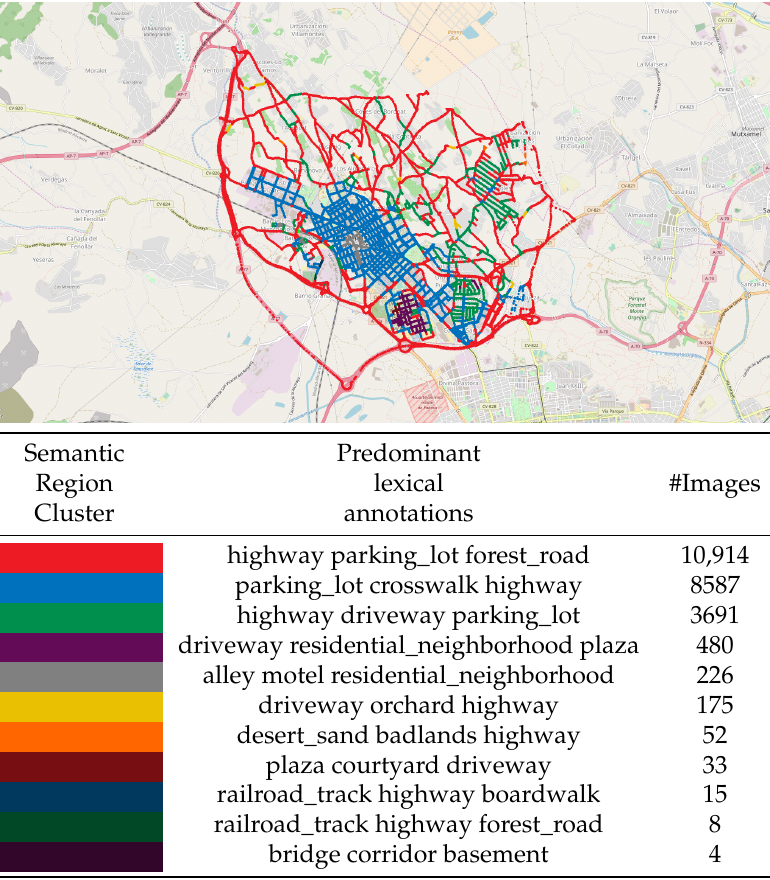
Figure 19. Semantic map with Average-BrayCurtis-0.6 combination smoothed with K = 25, produc- ing 11